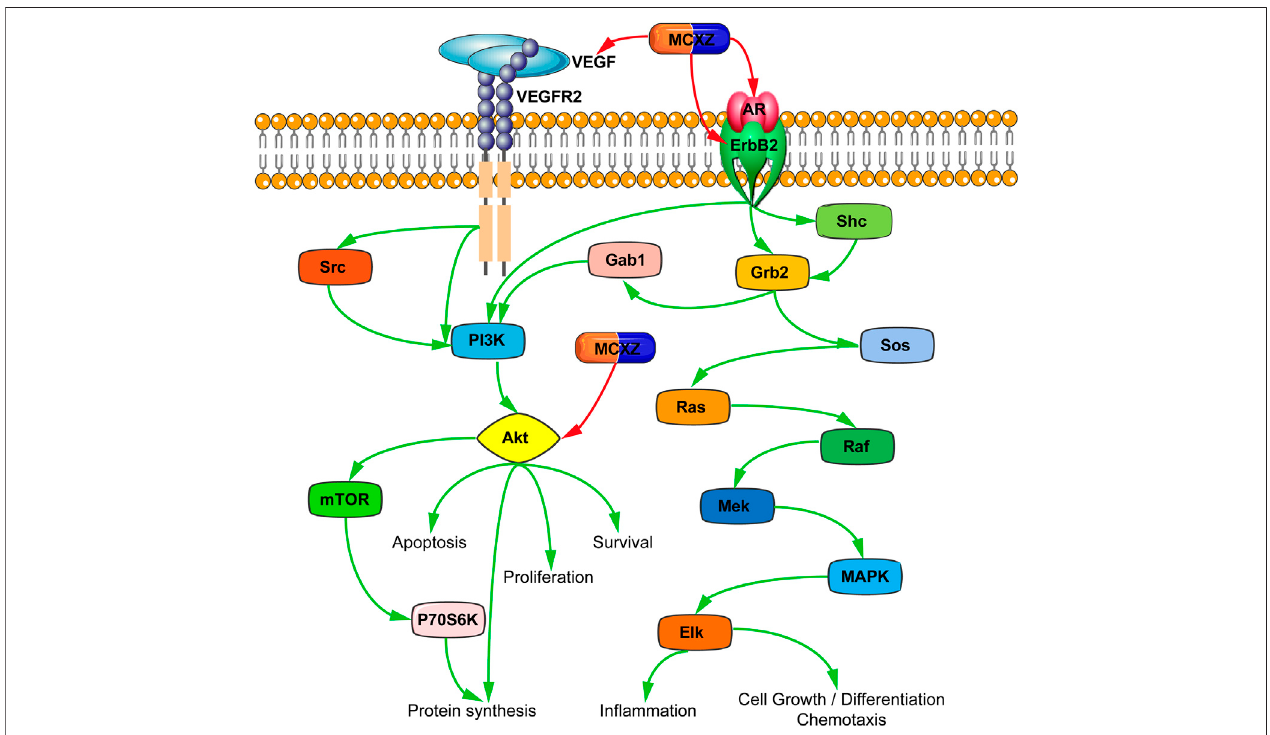
FIGURE 9 | Schematic Illustration of the main pathways of MCXZ in the treatment of